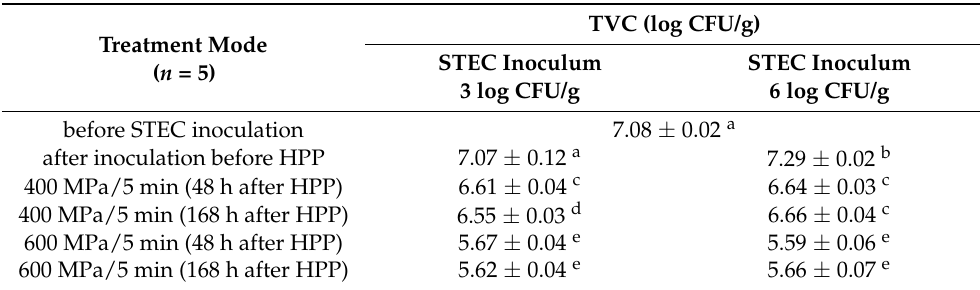
Table 1. Results for the TVC (mean ± standard deviation) in CFU/g in the product steak tartare following artificial inoculation with a cocktail of STEC of 3 and 6 log CFU/g and following pasteur- ization using HPP (high-pressure processing) at a pressure of 400 and 600 MPa.